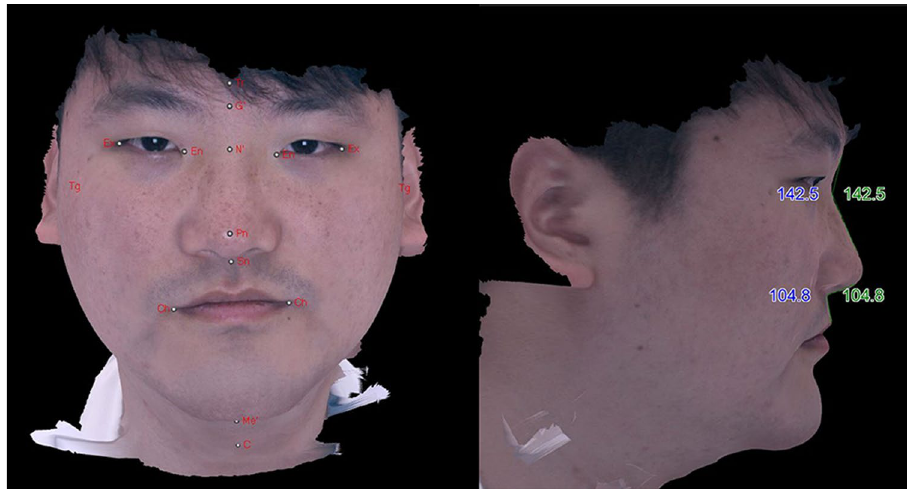
Figure 3. Reconstructed image of 3D scanning. Each landmark on the rendered image were detected and angular components were measured automatically through the landmarks. The landmarks can be readjusted by